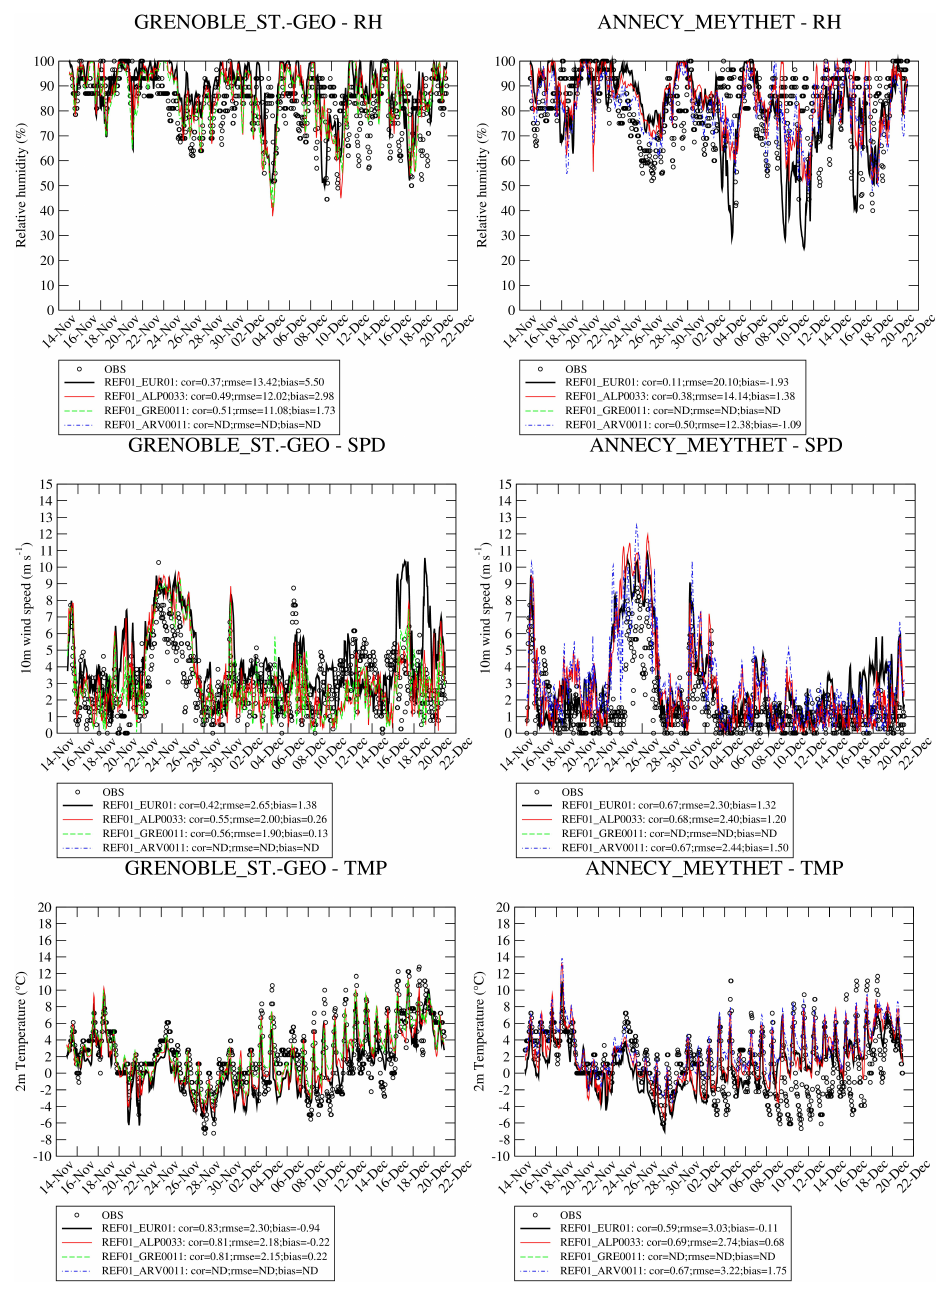
Figure 3. Hourly timeseries of meteorological variables (temperature, wind speed and relative humidity) at Grenoble and